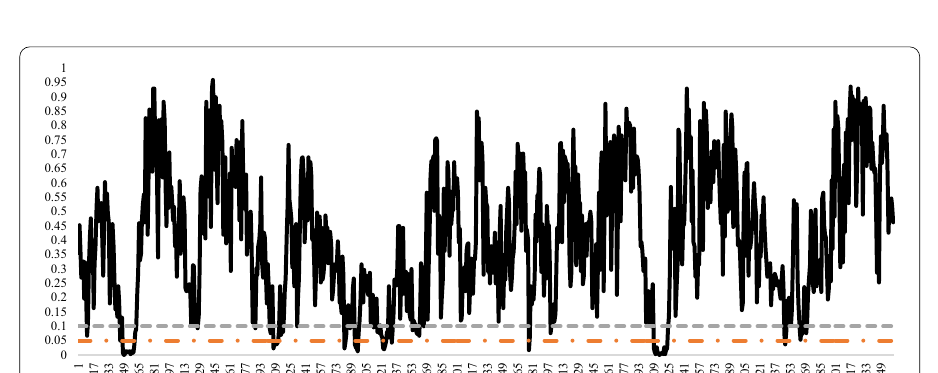
Fig. 31 The evolving p values of the GS test statistic checked for the Gold in 150-day window